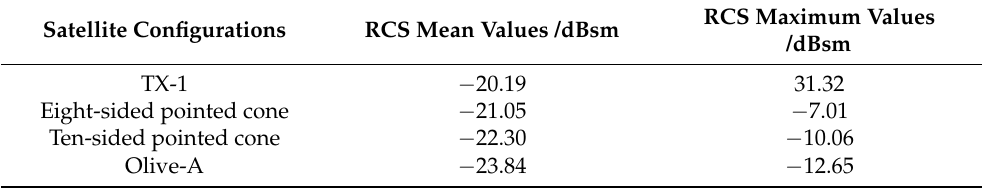
Table 2. Comparison of mean and maximum values of RCS at 10 GHz for 4 satellites.